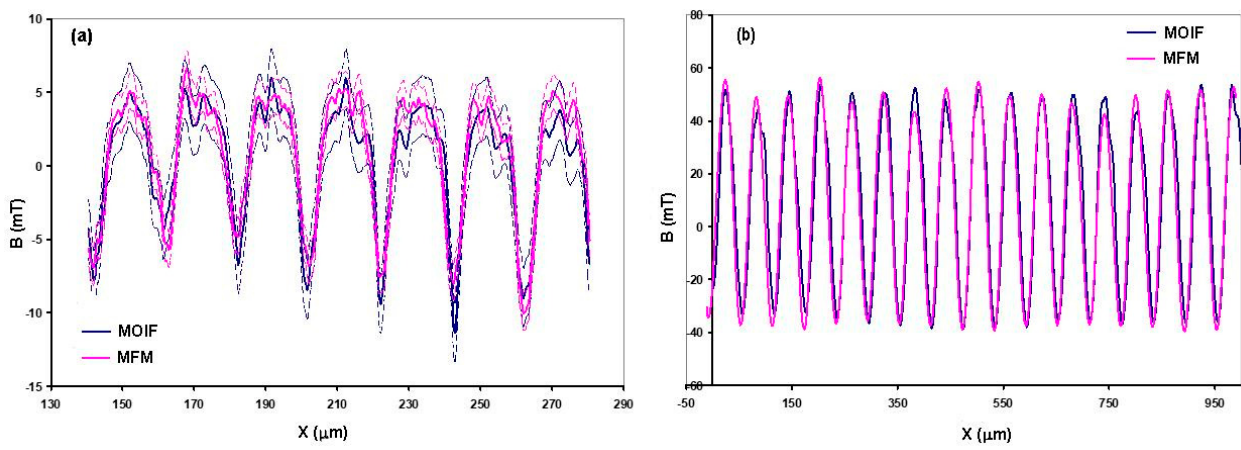
Figure 3. ( a ) MFM − MOIF comparison on thermomagnetically patterned NdFeB sample with 20 μ m periodicity. ( b ) MFM − MOIF comparison measurements on SENSITEC GmbH lithographically patterned NbFeB reference sample with 60 μ m periodicity performed using TUBITAK’s high-resolution magneto-optical system and PTB’s large range MFM. Both datasets show good agreement, thereby validating the calibrations of the systems.